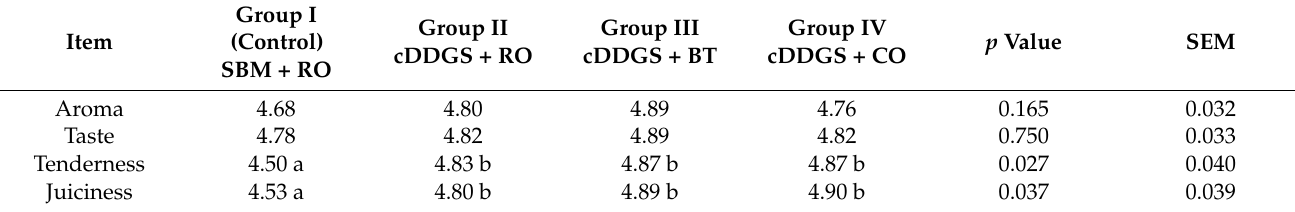
Table 5. Sensory traits of cooked meat ( longissimus